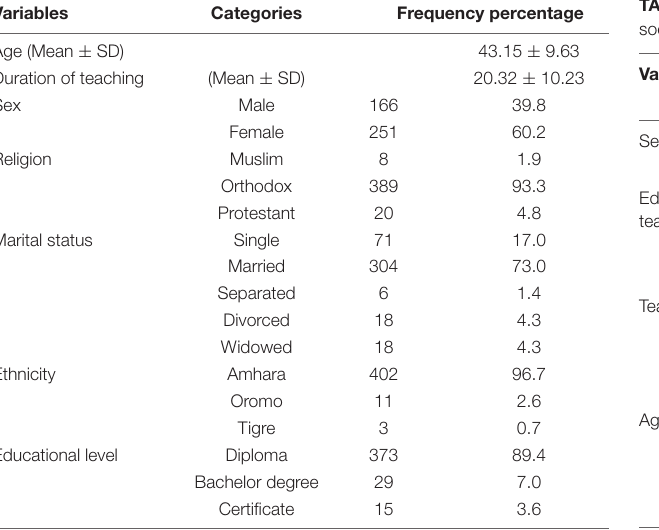
TABLE 1 | Sociodemographic characteristics of primary school teachers of Debre Markos and Dejen towns, 2018.